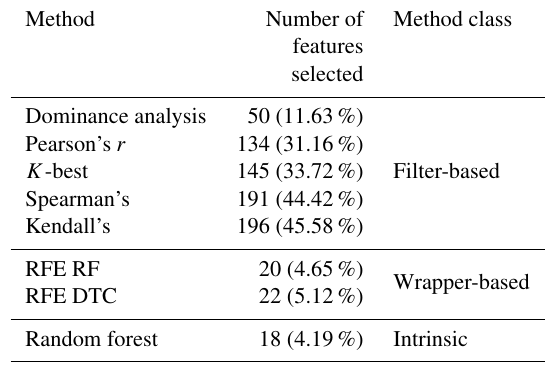
Table 1. Feature selection methods, classes and number of features selected.